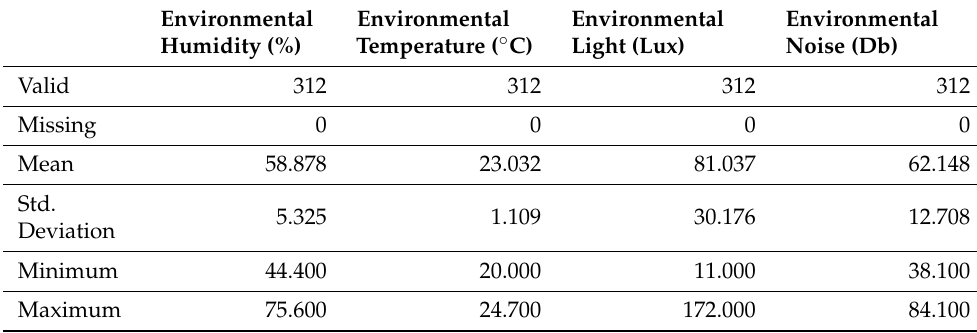
Table 2. Environmental variables.